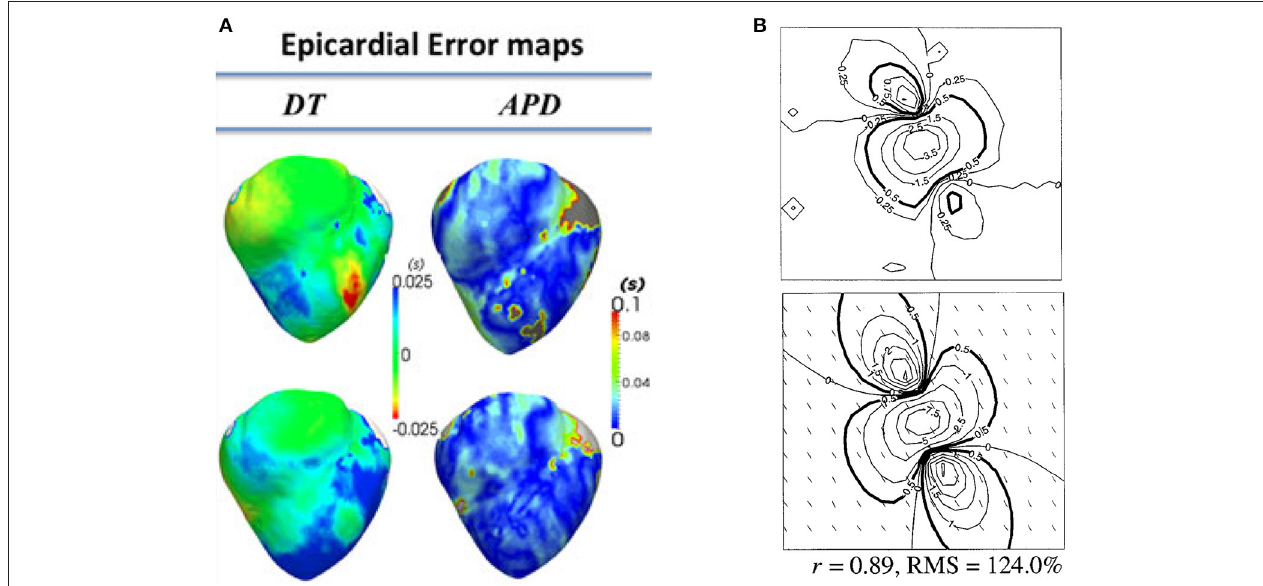
FIGURE 4 | Examples of quantitative validation of organ-level models. (A) Error maps (i.e., difference between model and experiment; here optical mapping-derived experimental data) for depolarisation time (DT) and APD (top row—pacing on left ventricle epicardium; bottom row—pacing on right ventricular endocardium) (Reproduced with permission from Relan et al., 2011). (B) Experimentally measured extracellular potential in mV using electrode plaque (top) compared to predictions of extracellular potential from bidomain simulations (bottom), with difference quantified using Pearson’s correlation coefficient (r) and root mean squared (RMS) error. (Reproduced with permission from Muzikant et al.,